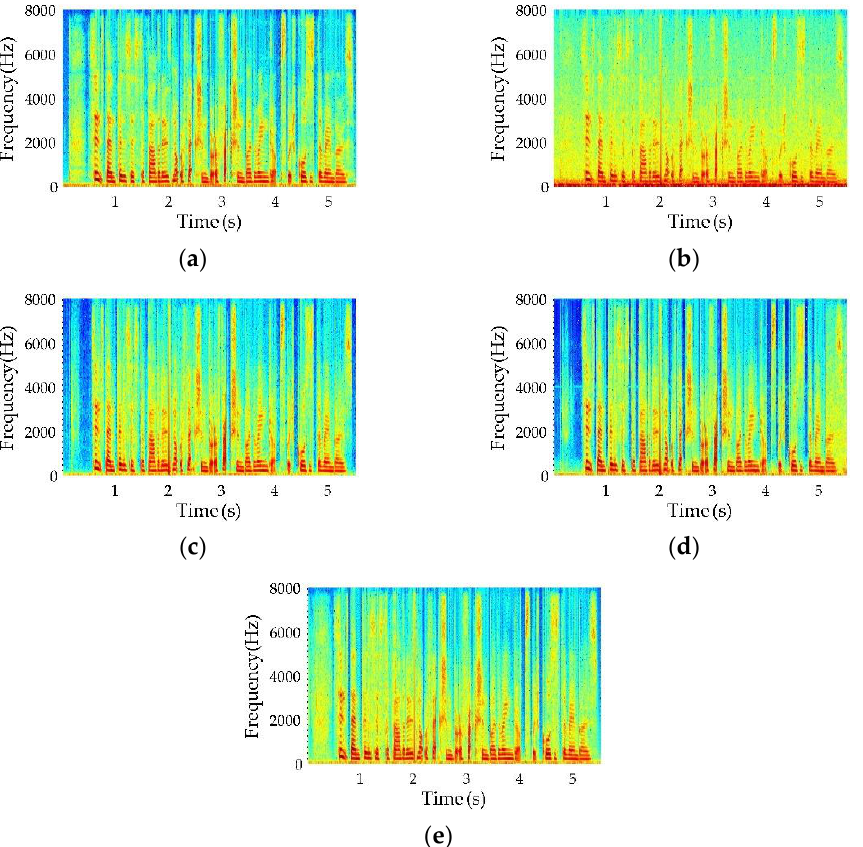
Figure 6. The spectrograms of speech enhanced by ( c ) Attention-Wave-U-Net [14], ( d ) SASEGAN [7] and ( e ) SECS-U-Net ( 𝐿 𝑎𝑙𝑝ℎ𝑎 ) on 560-Testset. The ( a ) and ( b ) are spectrograms of clean and noisy speech, respectively.